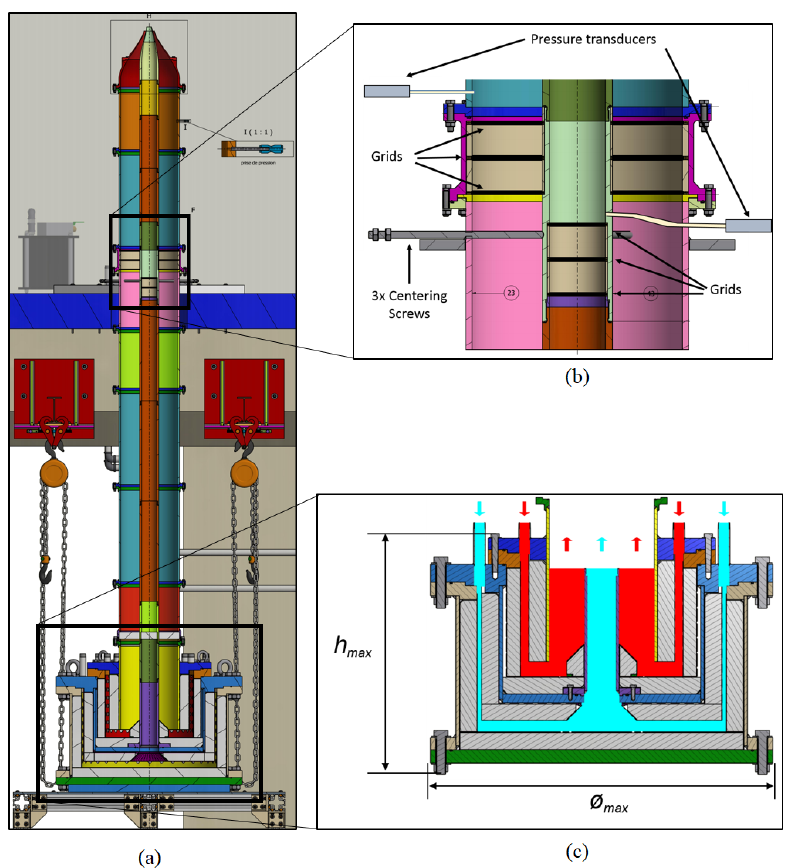
Figure 3. ( a ) Section of the silencer and coaxial ducts. ( b ) Detail of the ducts. The pressure tap of the primary flow is located below the grids of the secondary one, thus decreasing the risk of introducing vortex shedding noise. ( c ) Detail of the coaxial silencer. The clean passage areas for the primary and secondary flow are colored in cyan and red, respectively. The gray zones represents the acoustic absorbent material. The overall dimensions are h max = 0.76 m, D max = 0.98 m, weight m sil ≈ 1200